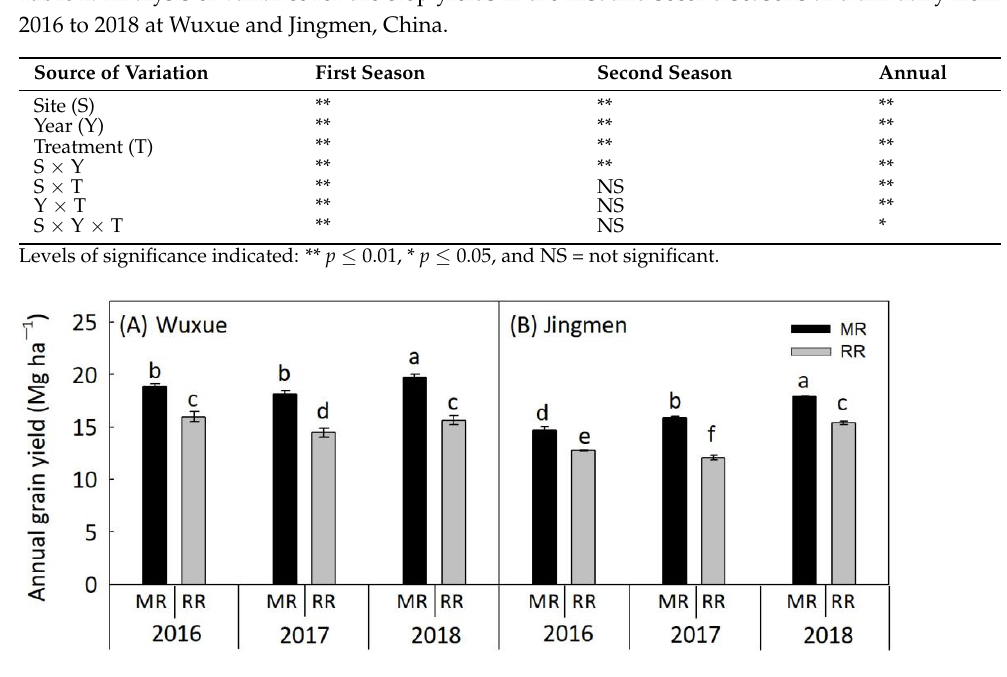
Table 2. Analysis of variance for the crop yields in the first and second seasons and annually from 2016 to 2018 at Wuxue and Jingmen, China.